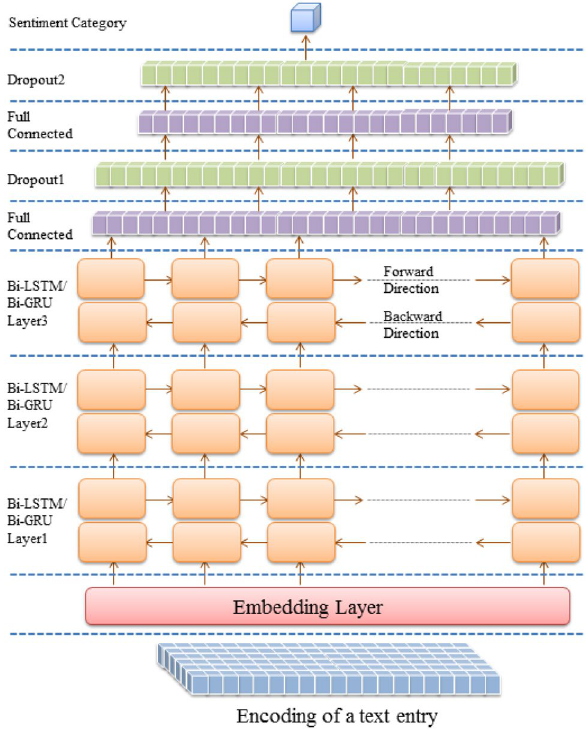
Figure 2. Bi-LSTM/Bi-GRU architecture (created by Microsoft PowerPoint 2010).